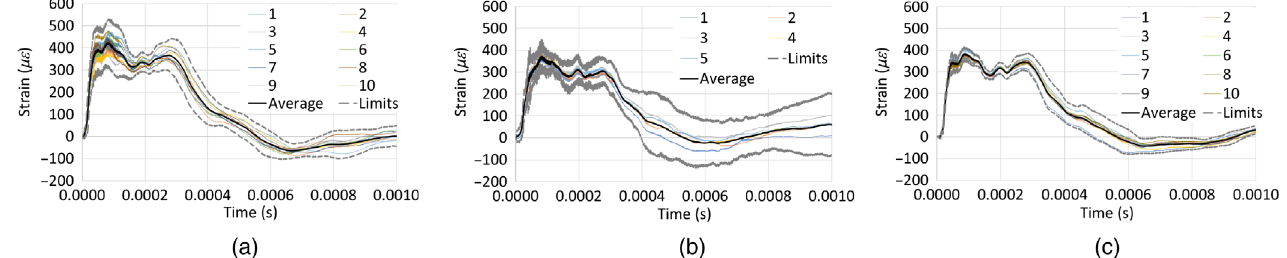
T28.FIG. 8. Tolerance interval calculations of sensor T strain measurement data from T26 (a), T27 (b), and T28